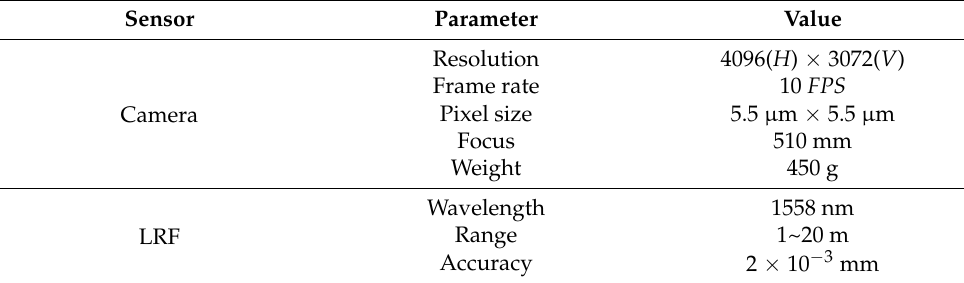
Table 3. System parameters of camera and LRF.